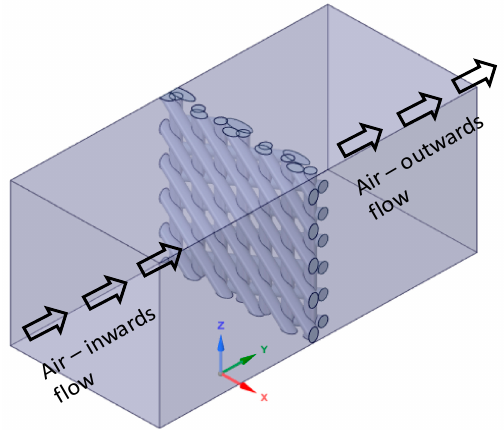
Figure 4. Compressed air flow through cellular coupons shown for D3 sample.